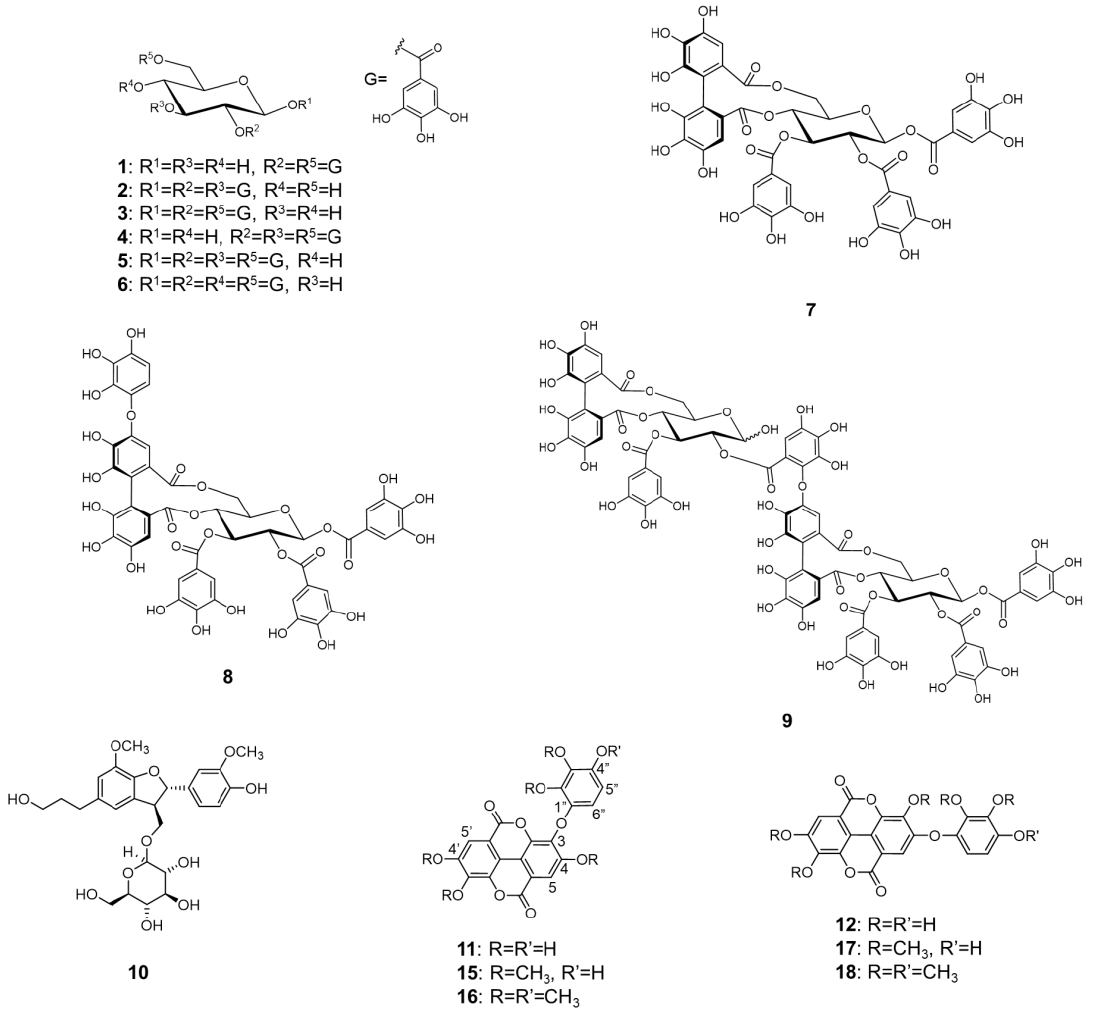
Figure 1. Chemical structures of the polyphenols isolated from TBE and the methylated compounds of 11 and 12 .